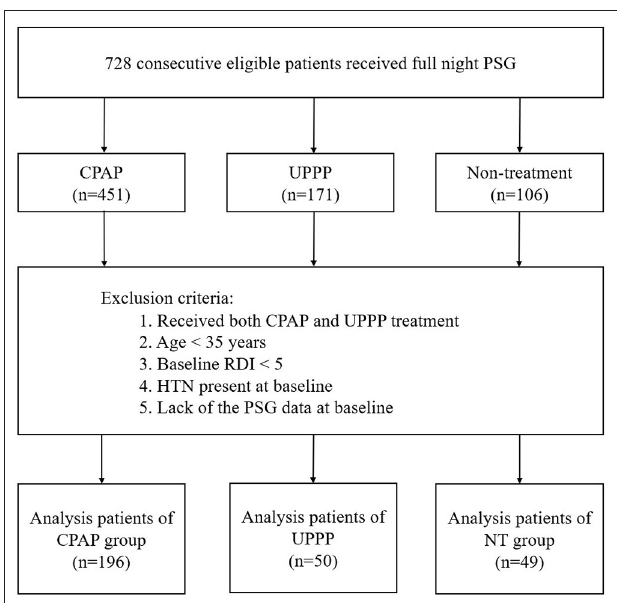
FIGURE 1 | Enrollment of the study patients. CPAP, continuous positive airway pressure; UPPP, uvulopalatopharyngoplasty; RDI, respiratory disturbance index; OSA, obstructive sleep apnea; NT,